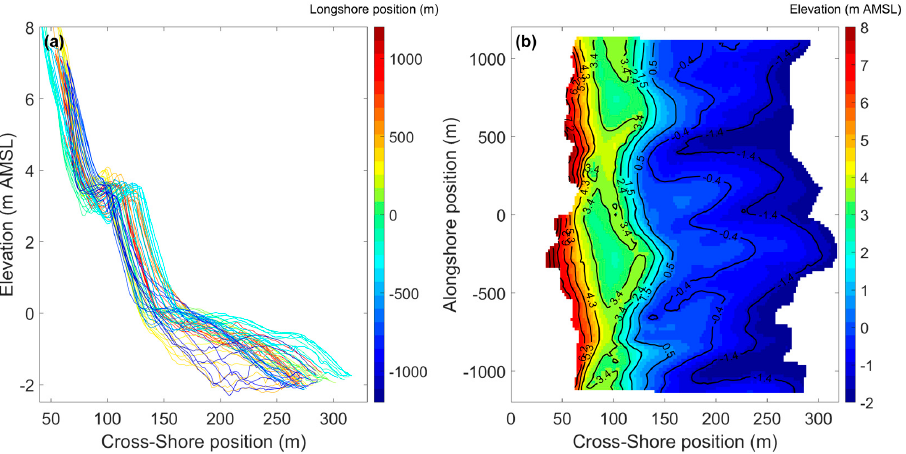
Figure 2. Truc Vert beach DEM on 11 September 2018: ( a ) superimposed 20 m spaced beach profiles and ( b ) planview DEM.